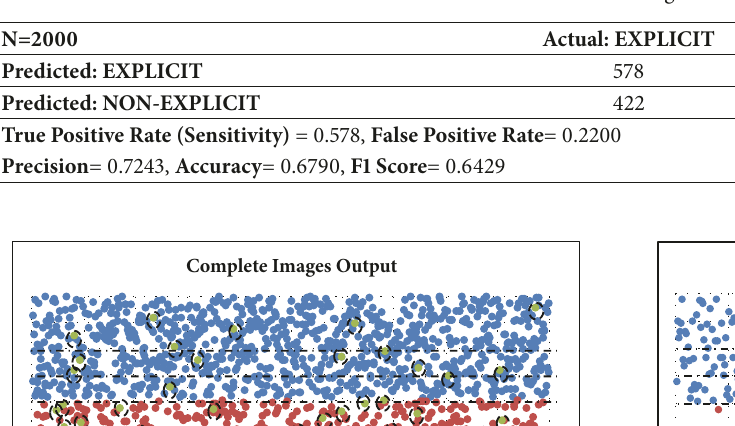
Table 4: Confusion matrix for image dataset using YCBCR.